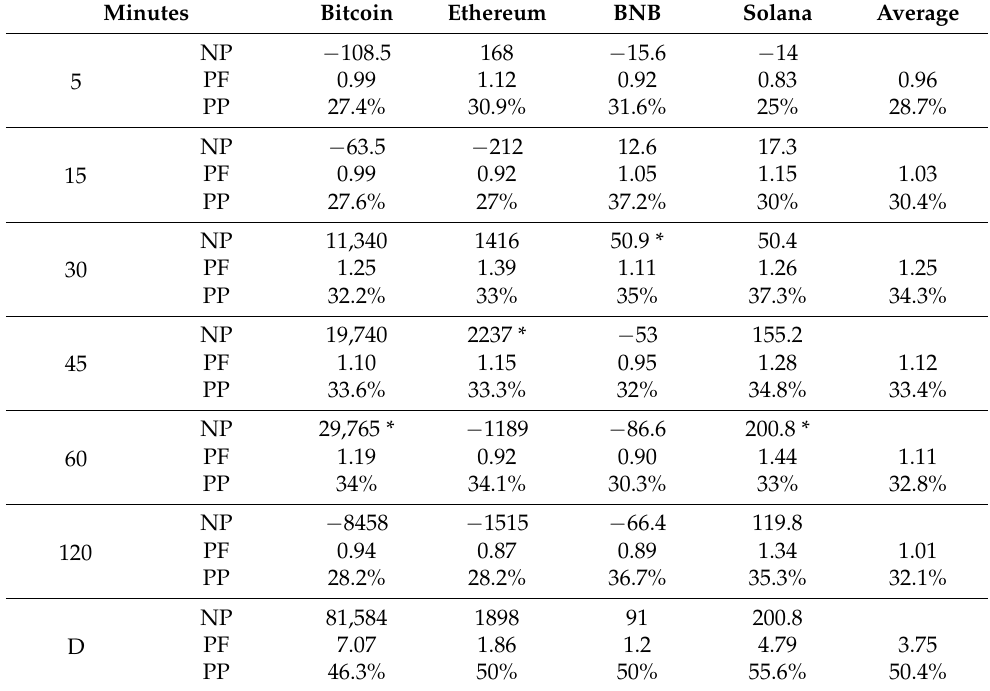
Table 4. Results of Ichimoku cloud plus MACD trading